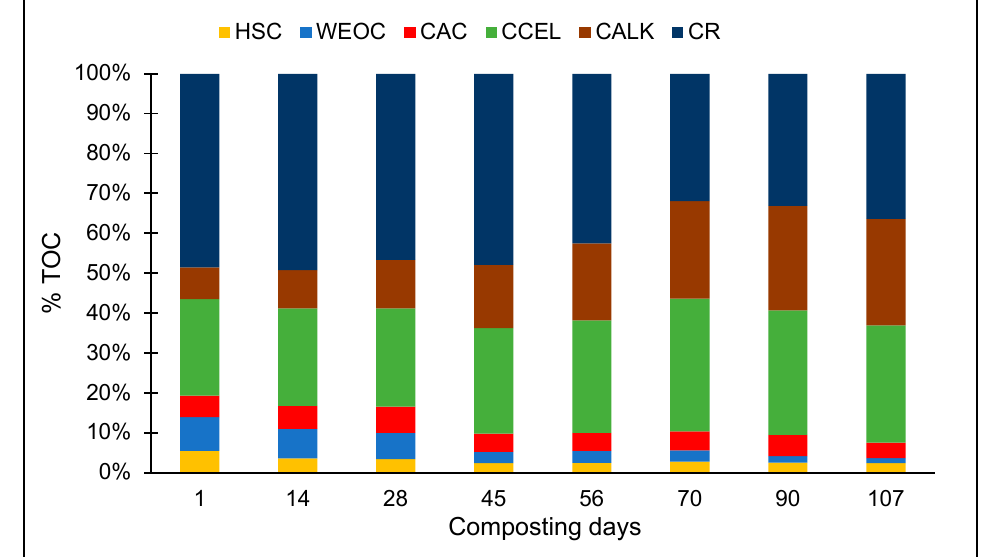
Figure 5. Changes in the share of the organic carbon of the extracted fractions in relation to TOC during the experiment.